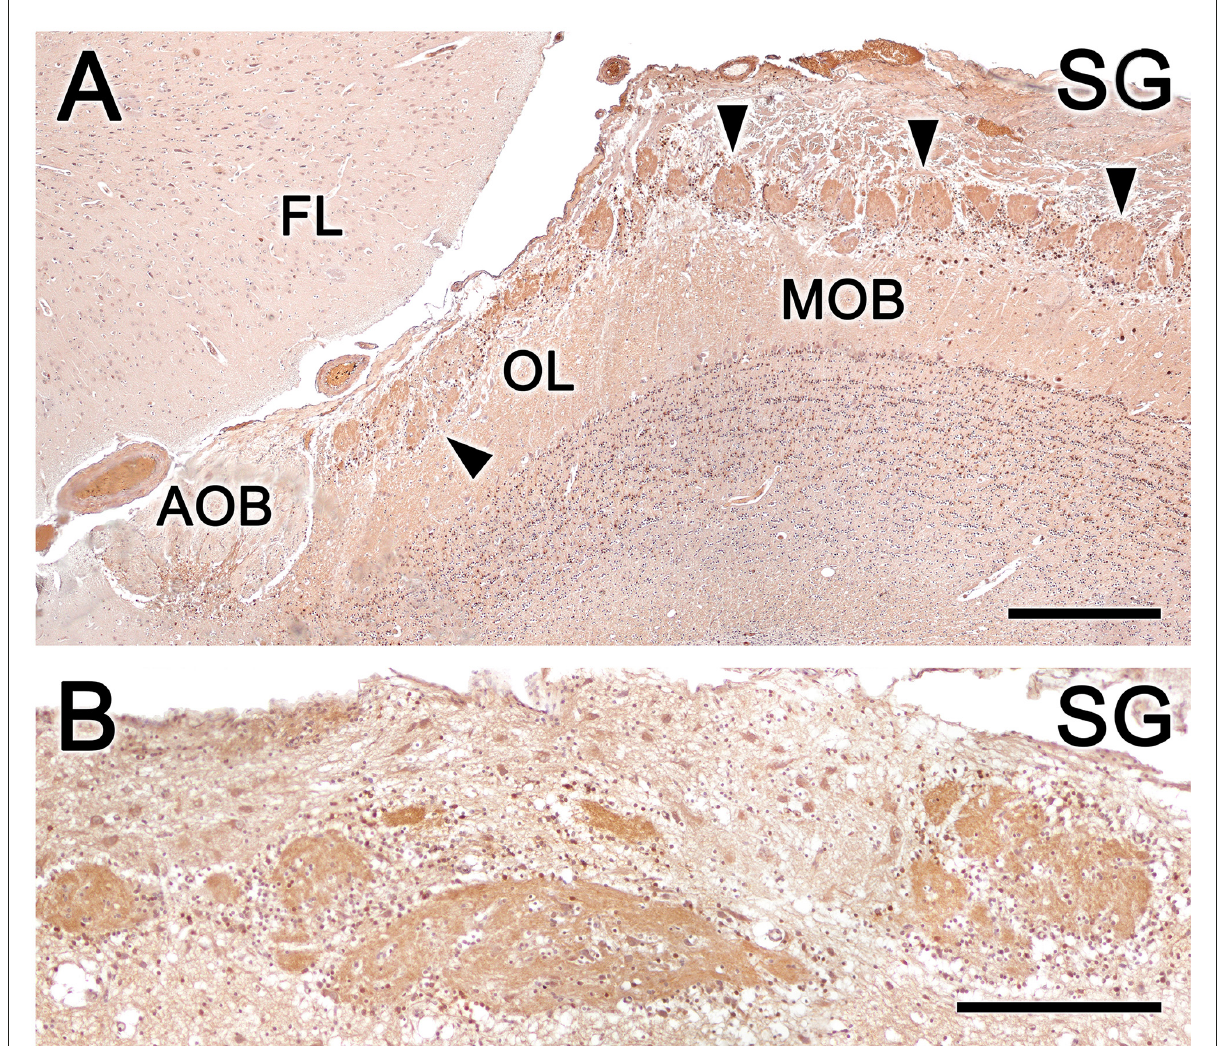
FIGURE11 Fox olfactory limbus (OL) sections immunolabeled for the calcium-binding protein secretagogin (SG) and counterstained with hematoxylin. (A) Anti-SG immunostaining results in immunolabeling of the entire glomeruli population (arrowheads) in both the OL and the main olfactory bulb (MOB) but not the glomerular layer of the accessory olfactory bulb (AOB). Periglomerular cells are intensely labeled. (B) In the macroglomerular complex, both the neuropil and neurons are SG-immunopositive, with variable labeling intensity. FL, the frontal lobe of the telencephalon. Scale bars: (A) : 500 µ m. (B) : 250 µ m.